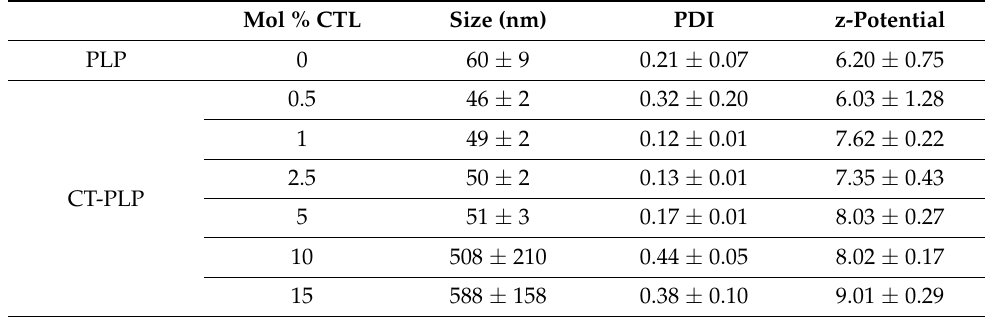
Table 2. Liposome characterization profiles.